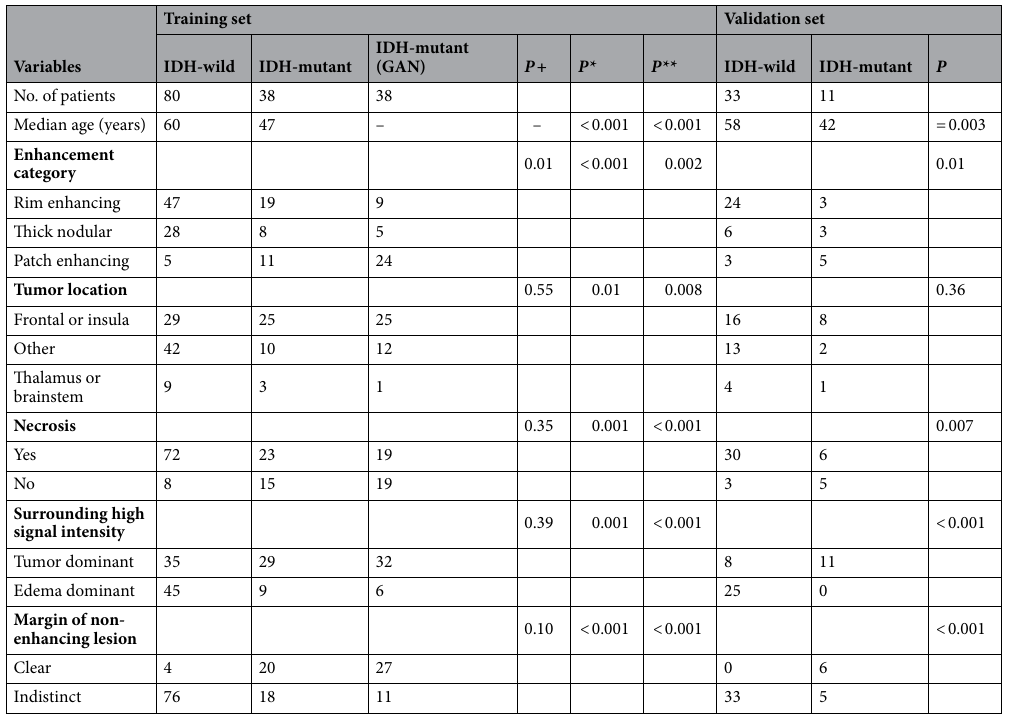
Table 1. Clinical and Imaging characteristics of the study patients. Data are expressed as the counts and median. P + indicates differences between real and synthetic IDH-mutant data. P * and P ** indicate differences between real IDH-wild type and real IDH-mutant data and between real IDH-wild type and synthetic IDH- mutant data, respectively. IDH isocitrate